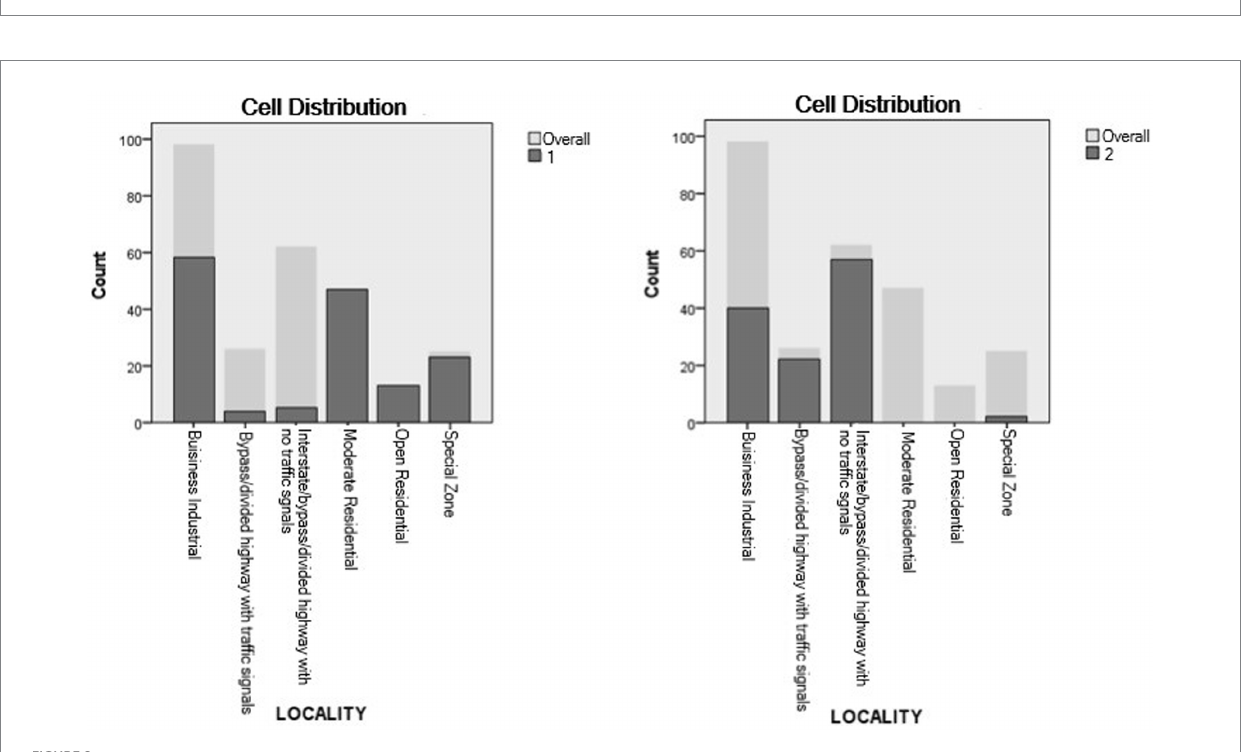
FIGURE 8 Locality distribution in